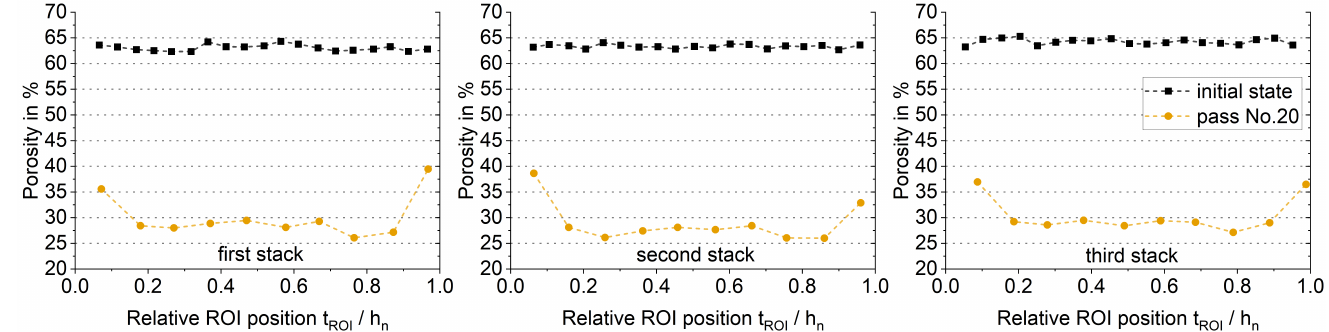
Figure A6. Series II: 5-0.50-20 ( l d / h m ≈ 0.8 − 1.2): Porosity change over relative sample depth (0=upper surface; 0.5= mid-section of sample; 1=lower surface) due to rolling for first, second and third